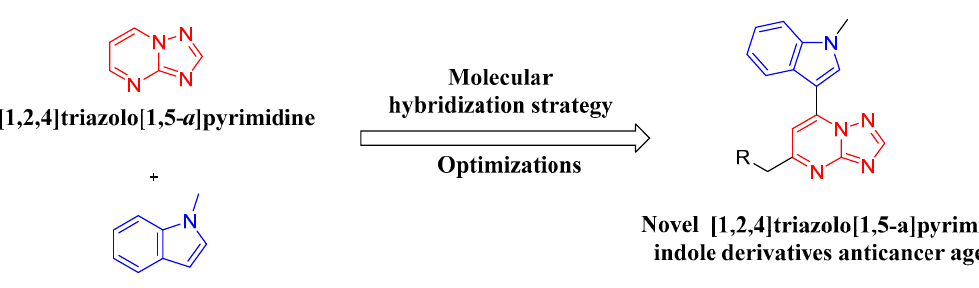
Figure 3. Design of [1,2,4]triazolo[1,5- a ]pyrimidine indole derivatives.